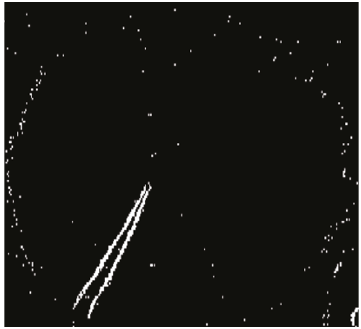
Figure 12: Image after boundary detection using our method with threshold of −